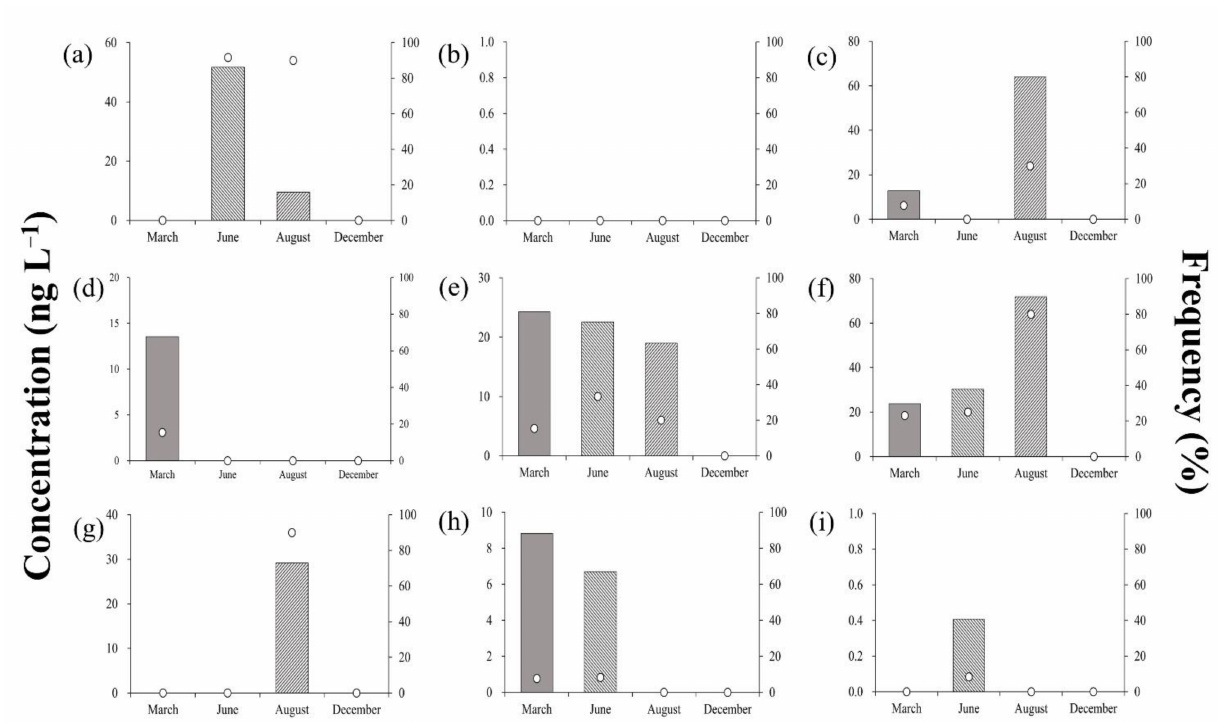
Figure 4. Residual concentrations and detection frequencies of antibiotics in surface water during the sampling campaigns: ( a ) Lincomycin, ( b ) Sulfachloropyridazine, ( c ) Sulfadimethoxine, ( d ) Sulfadiazine, ( e ) Sulfamethazine, ( f ) Sulfamethoxazole, ( g ) Sulfaquinoxaline, ( h ) Sulfathiazole, ( i )